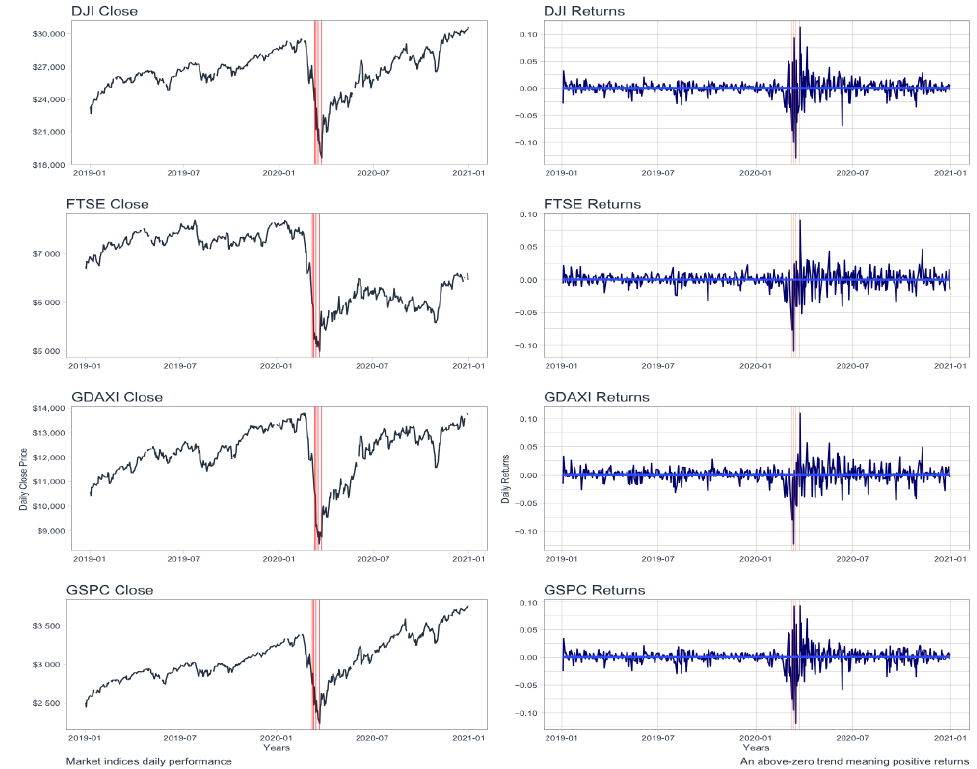
Figure 1. Stock market indices performance and returns period January 2019–December